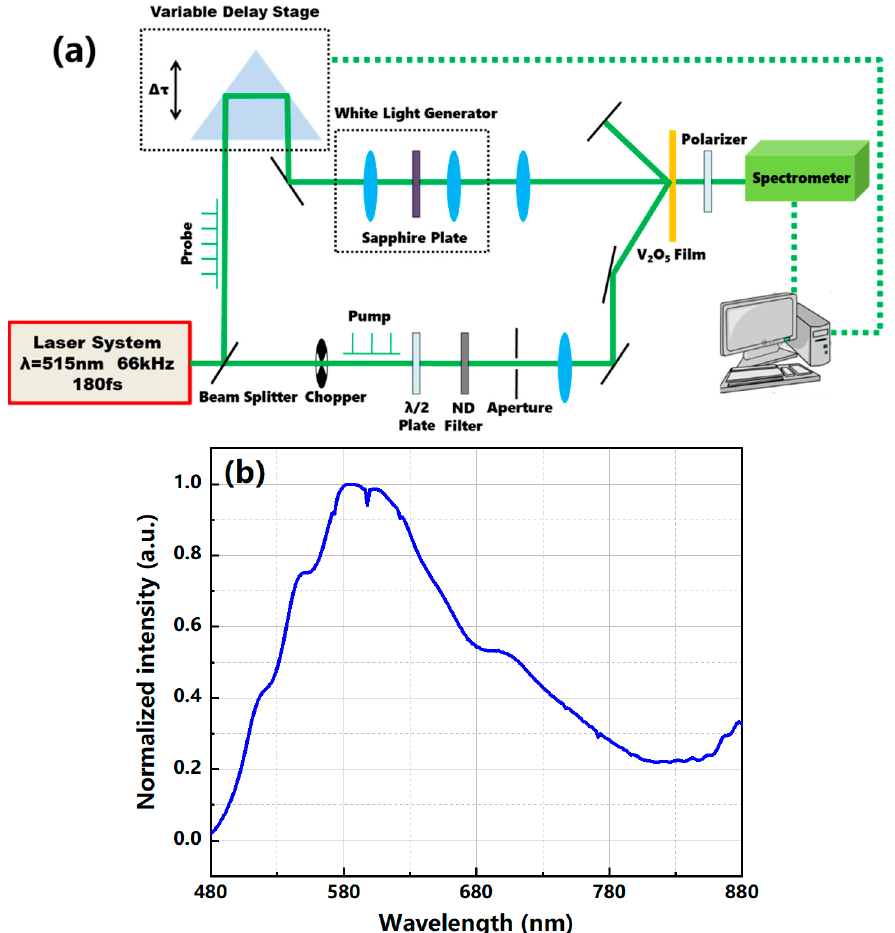
Figure 2. ( a ) Schematic of the ultrafast pump–probe setup. ( b ) Spectral distribution of the supercon- tinuum white light.